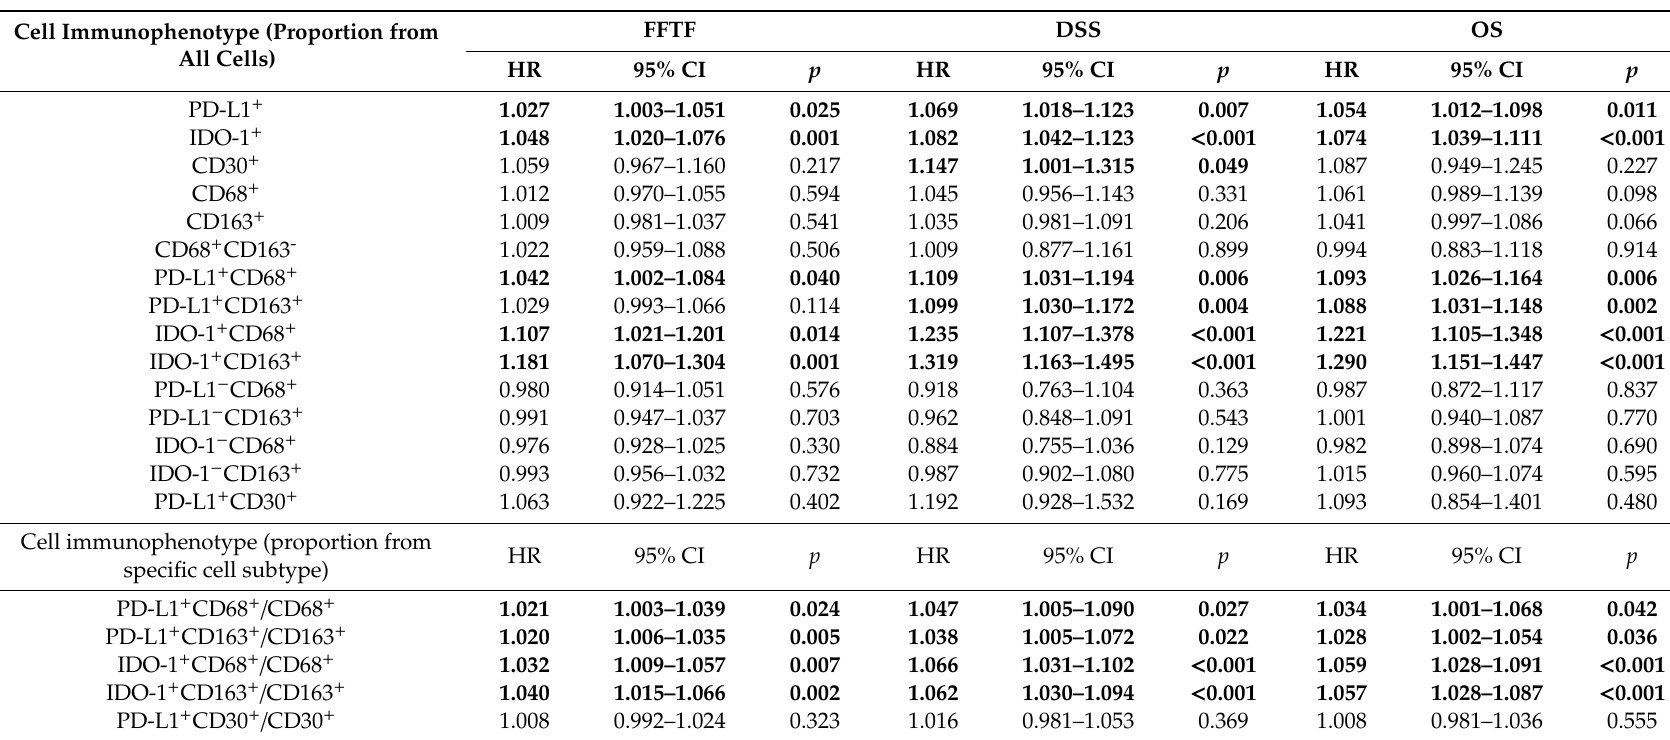
Table 3. Cox regression analysis as continuous variables at univariate level showing association of cell immunophenotypes with FFTF, DSS and OS. Cell Immunophenotype (Proportion from All